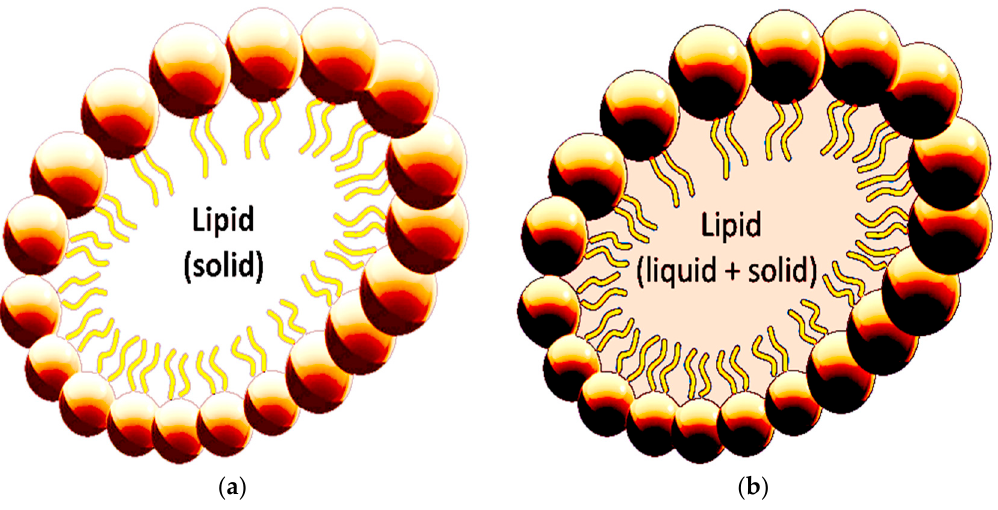
Figure 6. Structures of ( a ) solid lipid based nanocarriers ( b ) nanostructured lipid